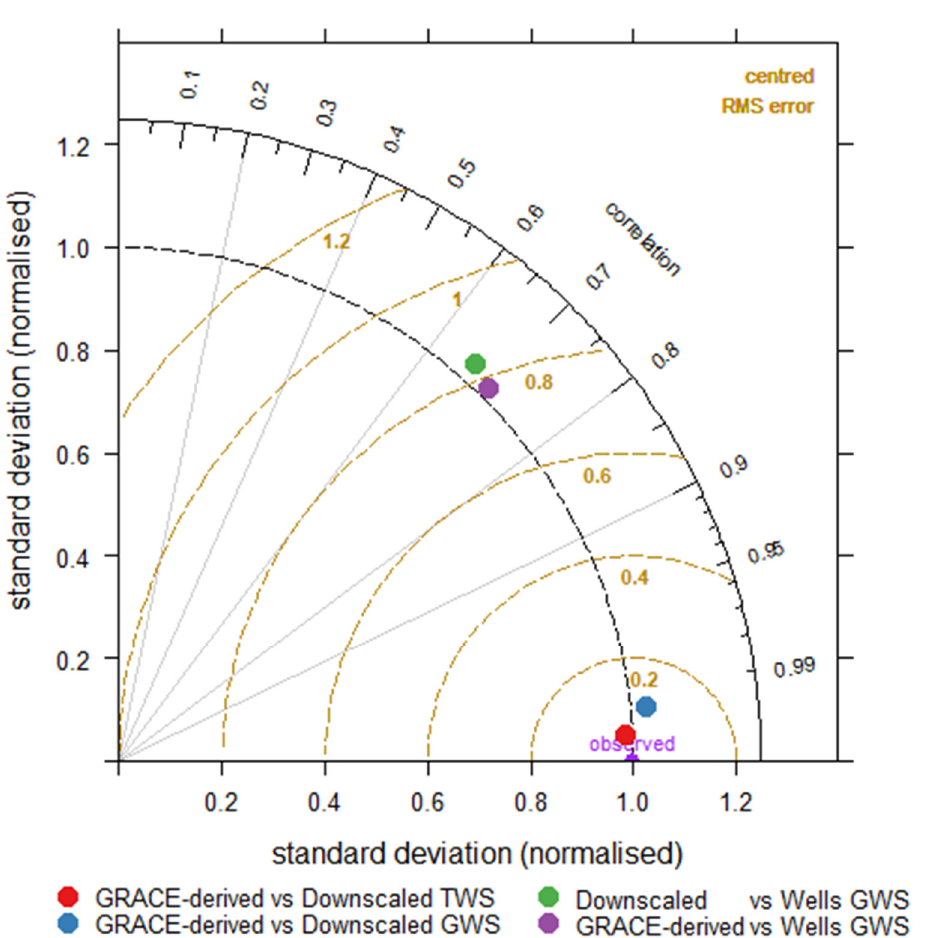
Figure 7. Taylor diagram showing the correlation coefficients, standard deviations, and root mean square errors (RMSE).